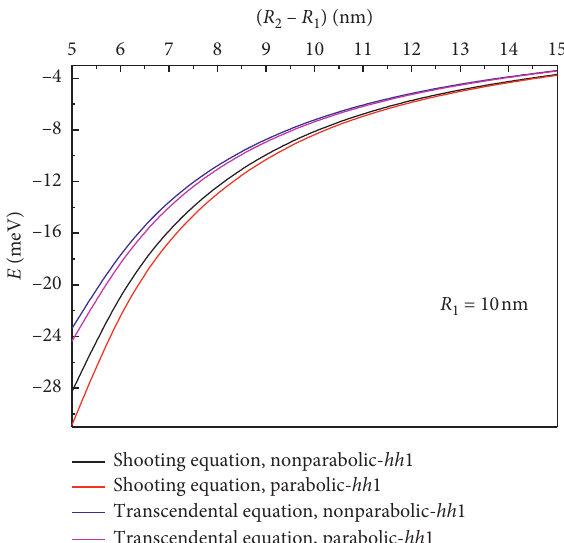
Figure 12: The dependence of the energy of a heavy hole on the thickness of a layer of a cylindrical quantum nanorod with a finite potential.